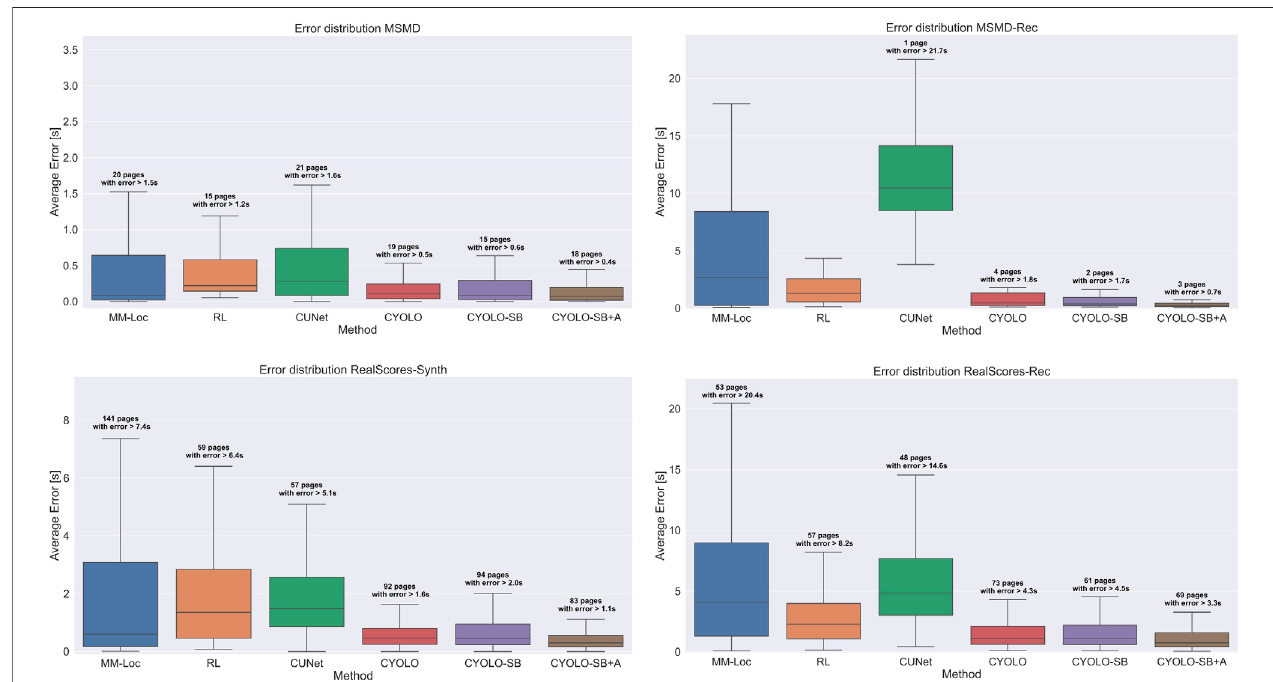
FIGURE 7 | Error distributions of compared methods across all test datasets. Outliers are not directly shown (in order not to skew the plots), but given as the number of pages with an error greater than 1.5 × the interquartile range for each method (if there are any).